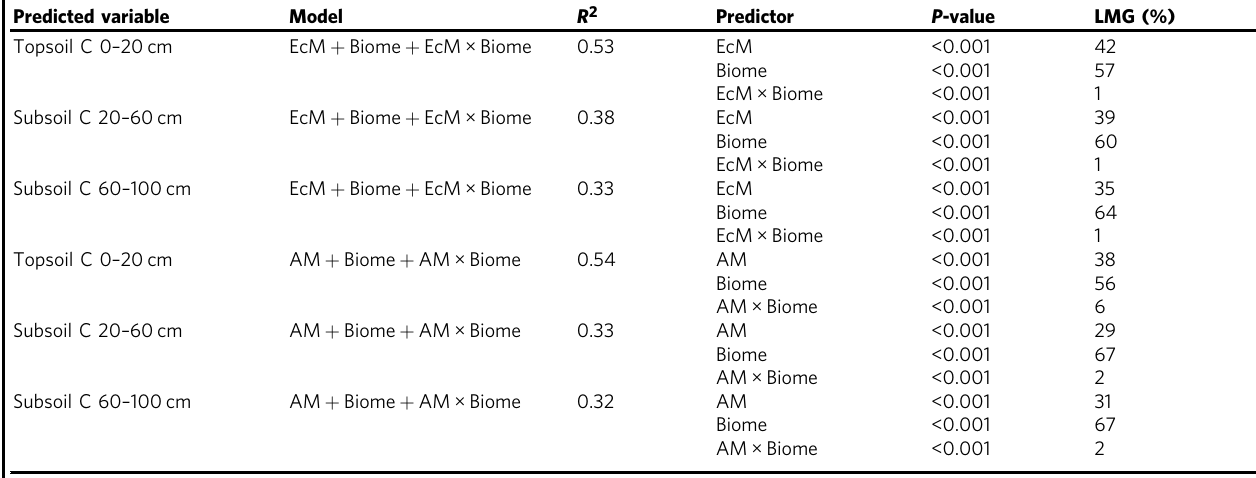
Table 1 Summary of generalized linear models (glm) predicting soil carbon stocks Predicted